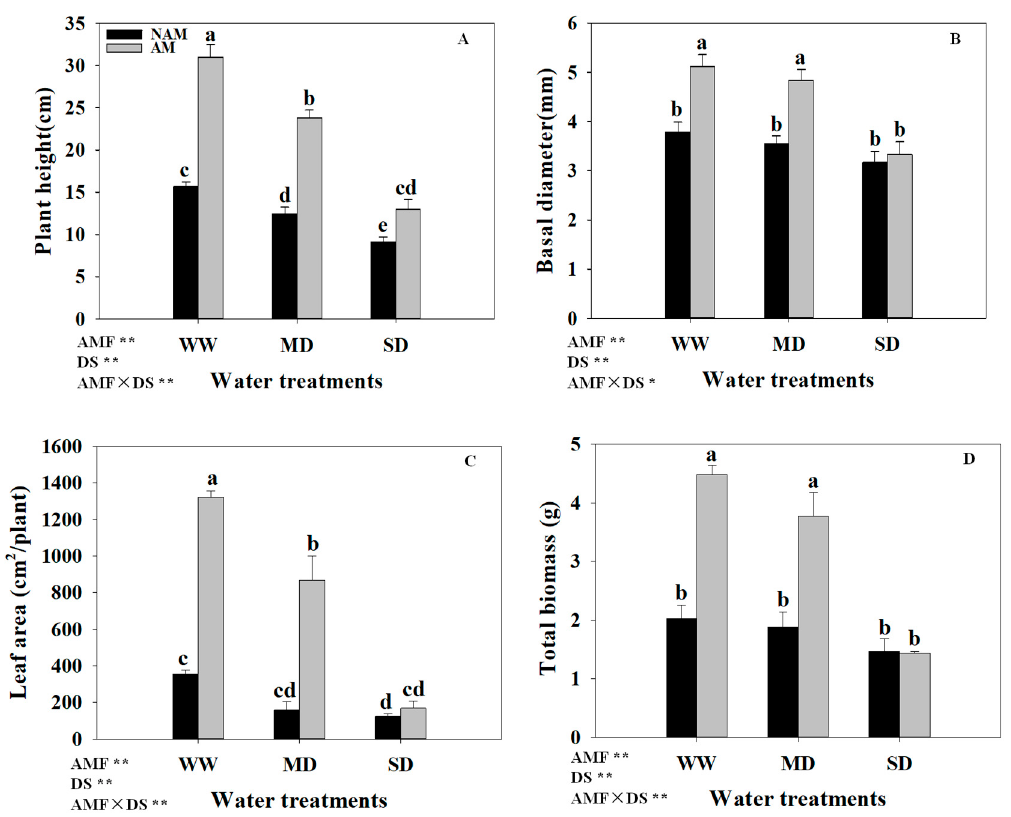
Figure 3. Effect of arbuscular mycorrhizal fungus (AMF) Rhizophagus intraradices on ( A ) plant height, ( B ) basal diameter, ( C ) leaf area and ( D ) total biomass of Catalpa bungei seedlings under DS. NAM, non-AMF-inoculated; AM, AMF-inoculated; WW, well-watered; MD, moderate drought; SD, severe drought; DS, drought stress. Different lowercase letters above the bars indicate significant differences ( p < 0.05) among treatments. Values are means ± SE. Plant heights and basal diameters are based on 9 biological replicates, while leaf area and total biomass represents the average of three biological replicates. Two-way ANOVA output: ns, not significant; * p < 0.05; ** p <